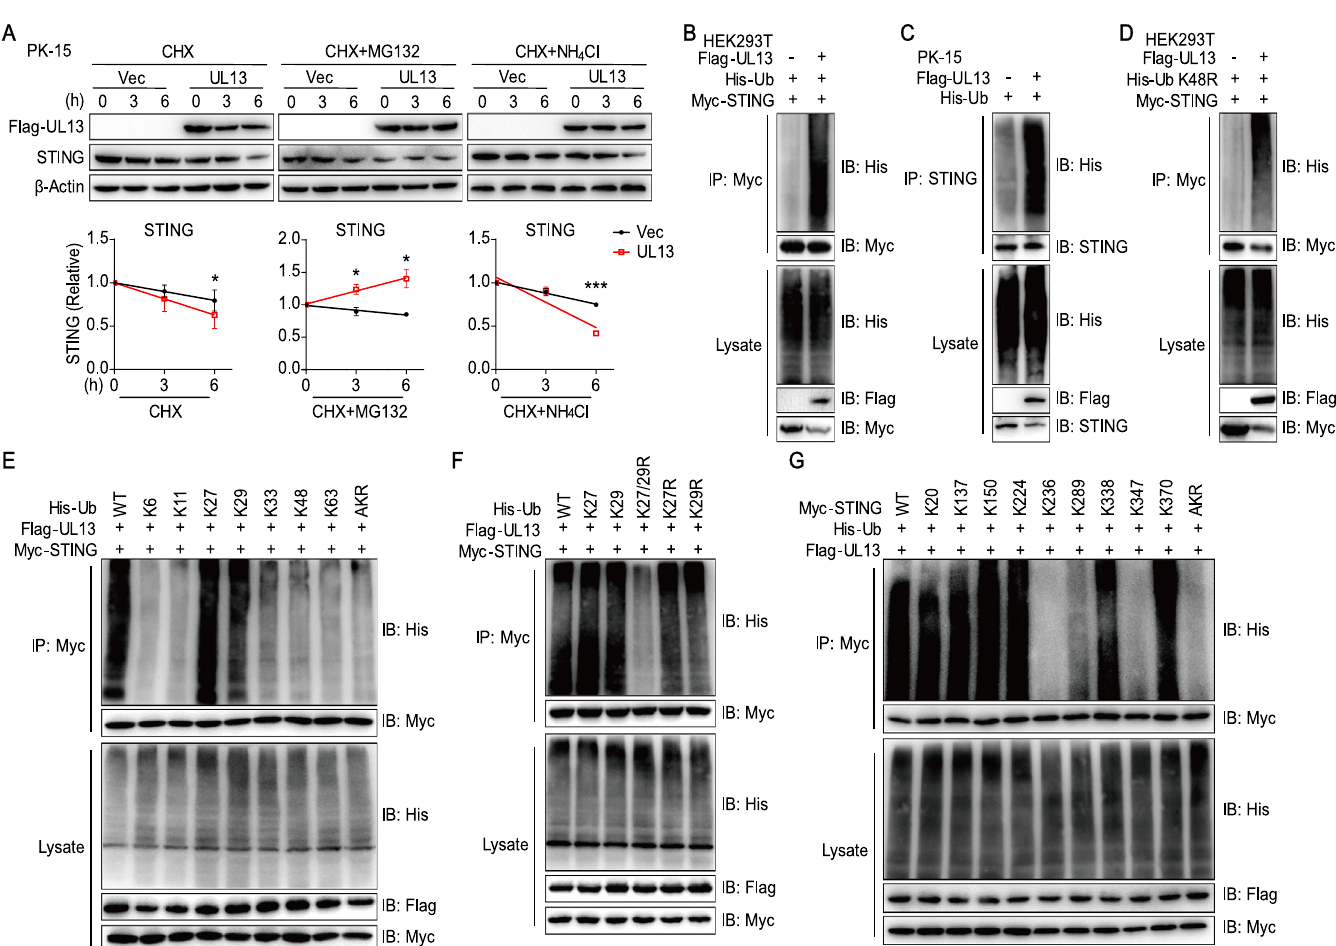
Fig 4. UL13 targets STING for K27-/K29-linked ubiquitination and degradation. (A) Immunoblotting analysis of STING protein expression in whole-cell lysates of PK-15 cells transfected with UL13 expression plasmid or empty vector following treatment with cycloheximide CHX (left), MG-132 (middle), or NH 4 Cl (right) (10 μ M) for the indicated times, respectively. Densitometric quantitation of STING was normalized relative to the levels of 0 h conditions (A, lower). (B-D) Immunoprecipitation analysis of HEK293T cells expressing His-Ubiquitin (Ub) and Myc-STING together with or without Flag-UL13 (B), PK-15 cells expressing His-Ub with or without Flag- UL13 (C), or HEK293T cells expressing His-Ub K48R mutant (Lys-to-Arg mutant at position 48 only) and Myc-STING together with or without Flag-UL13 (D). (E) Immunoprecipitation analysis of HEK293T cells expressing Flag-UL13 and Myc-STING together with wild type (WT) His-Ub or His-Ub mutants at K6, K11, K27, K29, K33, K48, and K63 only; or Lys-to-Arg mutants of all Ub lysines, AKR) as indicated. (F) Immunoprecipitation analysis of HEK293T cells expressing Flag-UL13 and Myc- STING together with WT His-Ub, His-Ub at K27 or K29 only or His-K27R, K29R, or K27/29R only mutants as indicated. (G) Immunoprecipitation analysis of HEK293T cells expressing Flag-UL13 and His-Ub together with wild type (WT) Myc-STING or Myc-STING mutants (K20, K137, K150, K224, K236, K289, K338, K347, and K370 only; or Lys-to-Arg mutants of all STING lysines, AKR) as indicated. Anti-Myc (B, D-G) or anti-STING (C) immunoprecipitates were analyzed by immunoblotting with an anti-His, anti-Myc or anti-STING antibody. Levels of the transfected proteins were analyzed by immunoblotting with anti-Flag, anti-His, anti- Myc or anti-STING antibody as indicated. Data are representative of three (A, upper) or two (B-G) independent experiments, or pooled from three independent experiments (A, lower). � p < 0.05, ��� p < 0.001 (Student’s t